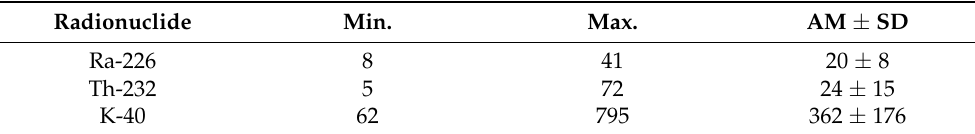
Table 8. Radionuclide concentration (Bq/kg) around the coal-fired power plant. Radionuclide Min.